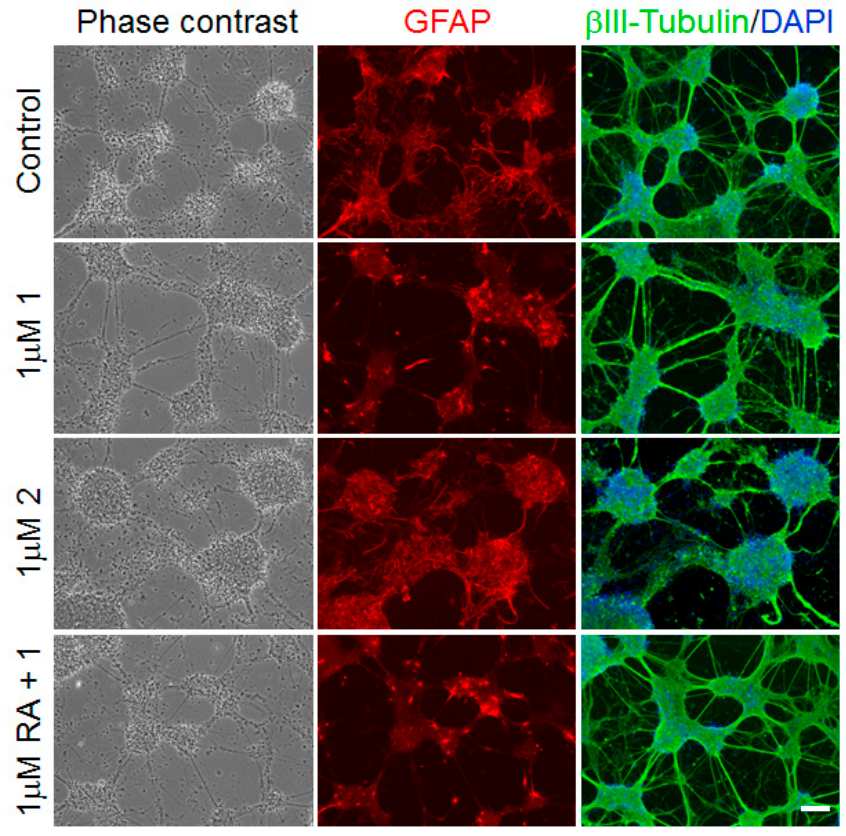
Figure 4. Immunostaining of primary neurons derived from E14, 5 forebrains treated with 1 µM of 1 , 2 or all- trans retinoic acid (RA) plus 1 . Blue: nuclei stained with DAPI; green: tubulin stained with β III-tubulin specific antibody; red: GFAP stained with α -GFAP antibody. Fluorescence microscope Zeiss Axiovert 200 M, 63× objective, 1024 × 1024 res. Scale bar: 50 µm.